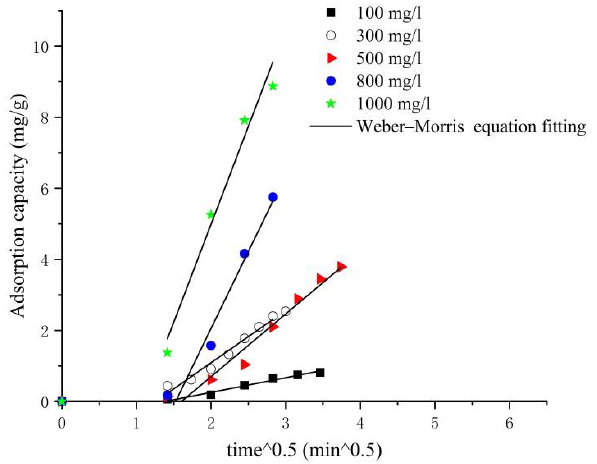
Figure 7. The curve of the electrosorption capacity with time under different concentrations.